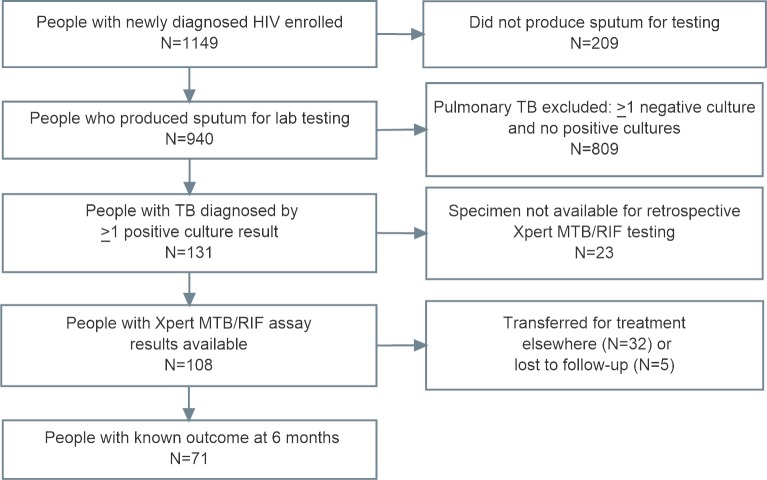
Flow diagram showing the study population.